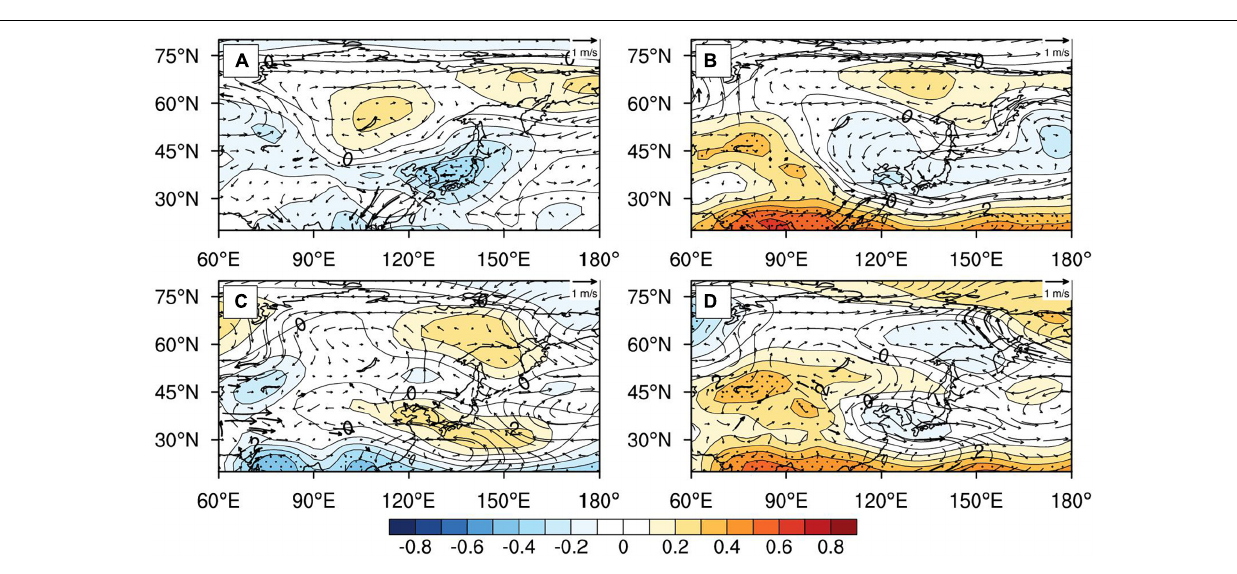
FIGURE 9 | Spatial distribution of regression coefficients of early winter 500 hPa height (contour) and 850 hPa wind (vectors) anomalies against the key area SST indices corresponding to the four types of the NCCV during 1979–2018. (A) EM type; (B) SLM type; (C) ESM type (D) SSM type. Dotted areas and bold arrows indicate the 99% significance